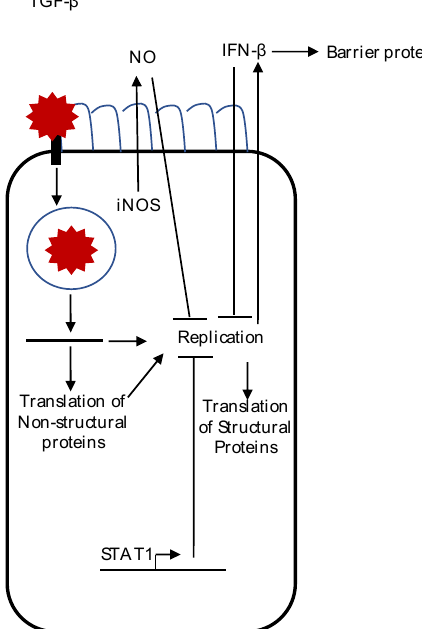
Figure 1. A summary of the innate immune response to astrovirus infection. After binding and entry into the cell, viral uncoating of the astrovirus genome occurs. Replication induces IFN ‐β production, which suppresses viral replication and translation of the structural protein, and decreases astrovirus ‐ induced barrier permeability. Synthesis of inducible nitric oxide synthase (iNOS) protein also occurs during astrovirus infection of epithelial cells. Although replication is not needed to induce iNOS in macrophages, whether or not iNOS induction occurs during astrovirus infection of epithelial cells is unknown. Active transforming growth factor beta (TGF ‐β ) levels are increased after astrovirus infection, but the role of TGF ‐β after astrovirus infection is not known. The presence of signal transducer and activator of transcription 1 (STAT1) decreases astrovirus replication, but the mechanism(s) remain to be determined.